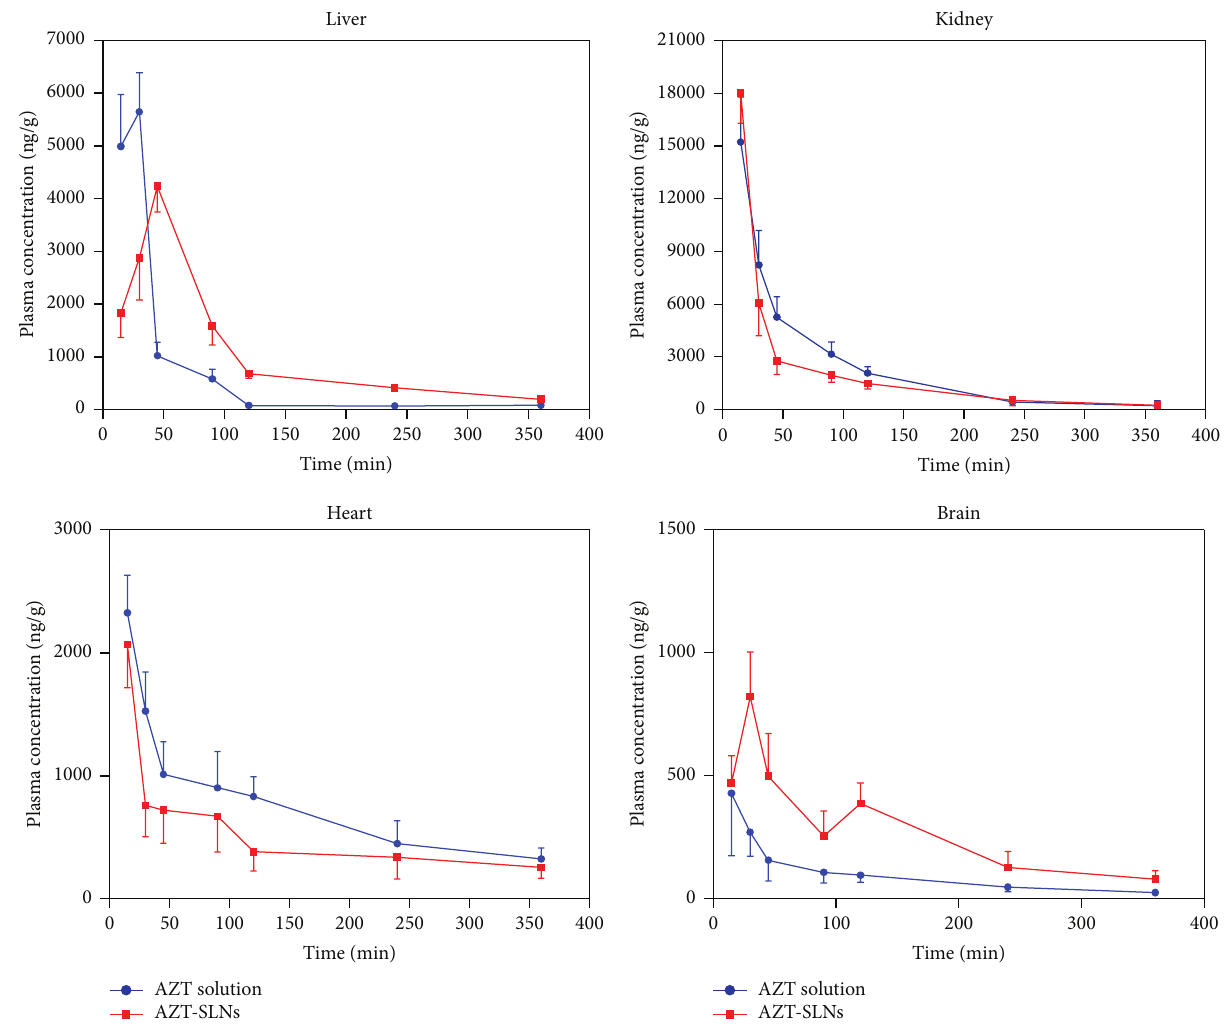
Figure 4: Mean concentration-time profile of various